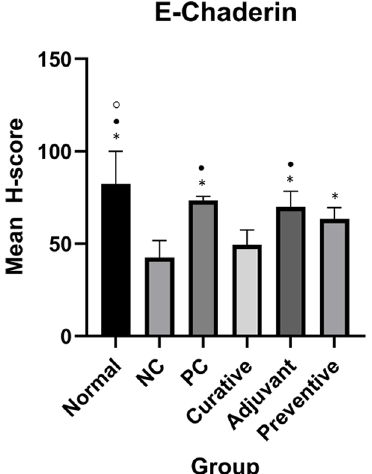
Figure 3. Expression of E-Cadherin in all groups. Duncan Test was used to determine the difference between groups. * represents significant difference (p < 0.05) of groups compared to NC. (cid:129) represents significant difference (p < 0.05) of groups compare to curative. ○ represents a significant difference (p < 0.05) of groups compare to